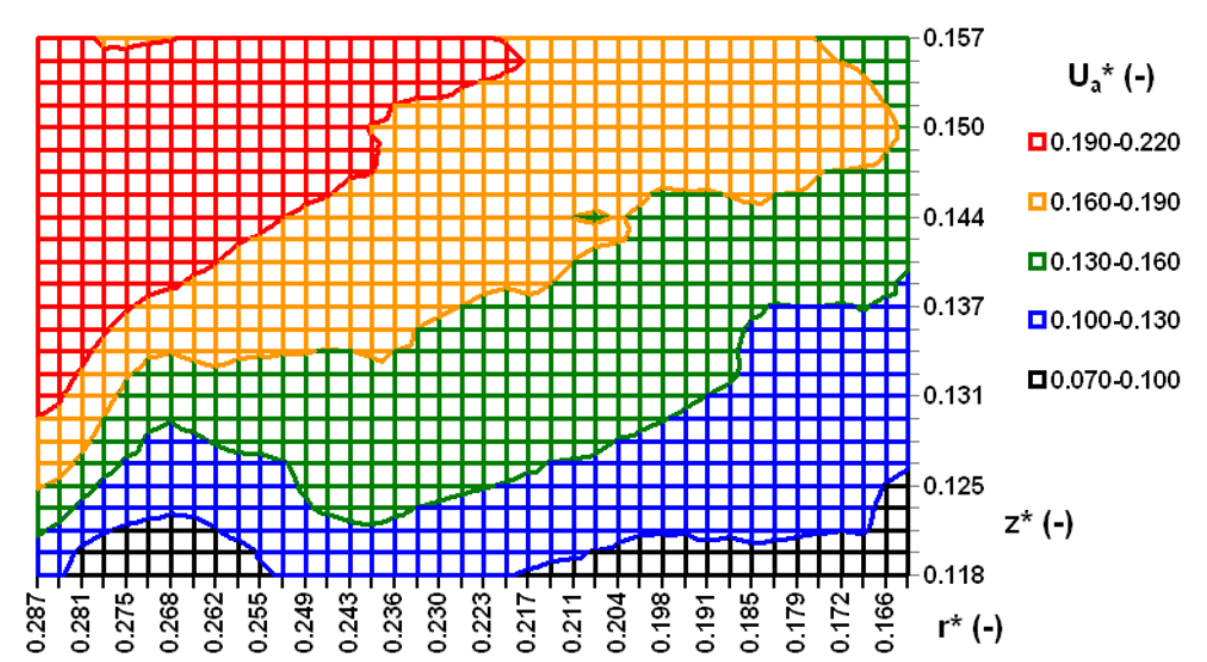
Fig. 3. Dimensionless axial mean velocity distribution U ax* = ) / ( N D U